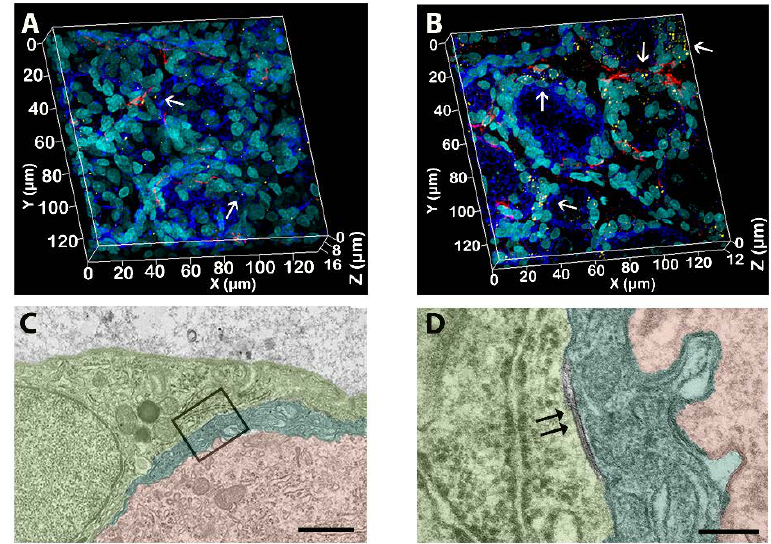
Figure 5. Qualitative analysis of gap junctions in the DRG. ( A ): Vehicle; ( B – D ): paclitaxel. Im- munofluorescence shows a higher level of Cx43 (arrows, yellow dots) and GFAP (red) expression in paclitaxel-treated DRG (SGCs nuclei in cyan, phalloidin neurons in blue). Electron microscopy shows a gap junction (double arrows) between two SGCs (dark and light green) that wrap a single neuron (red) in a DRG treated with paclitaxel ( D ): magnification from ( C ). ( C ) Bar: 2 µm; ( D ) bar: 0.25 µm.